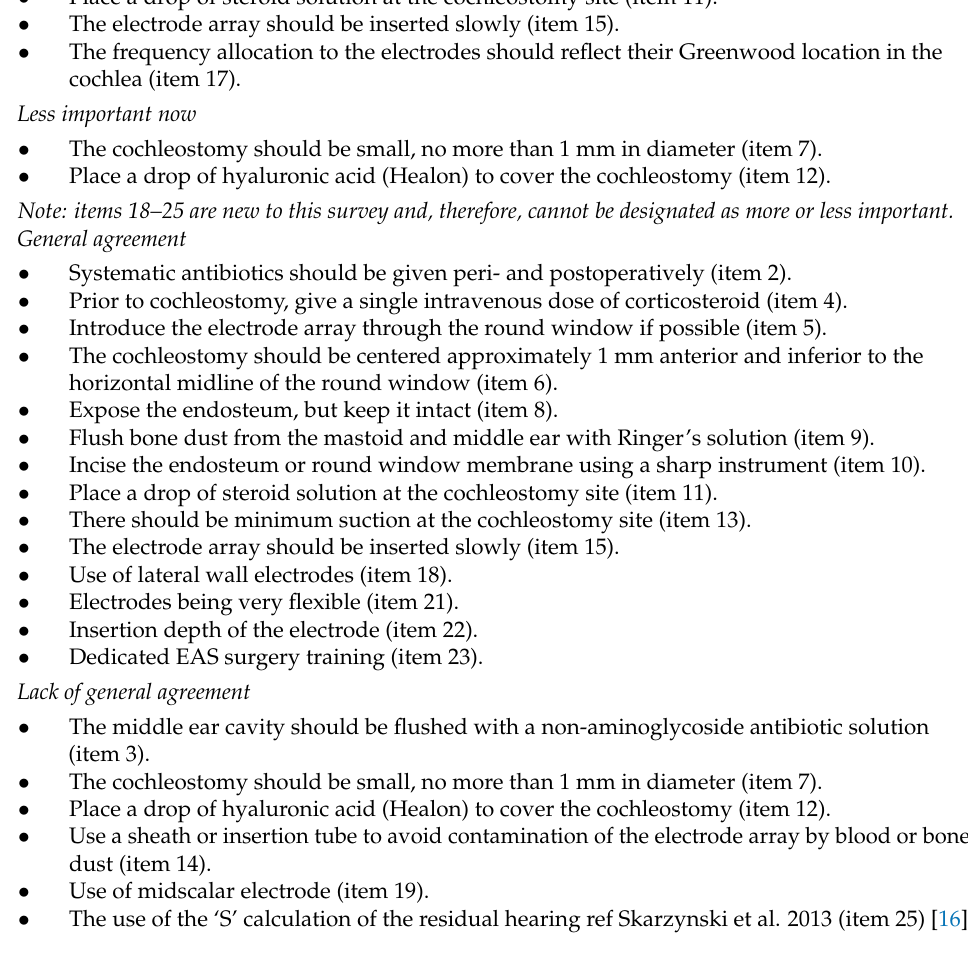
Table 3. A list of items that are regarded as more important or less important now (2020) compared to the 2010 survey and items for which there exists general agreement or a lack of general agreement. The Skarzynski et al. paper at the end of “Lack of general agreement” is reference [16] in this